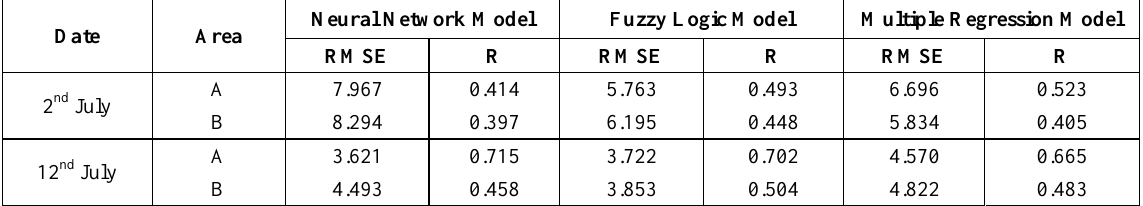
Table 3. Root means square error (RMSE) and correlation coefficient (R) of estimated soil moisture using neural network and fuzzy logic with ESTER soil moisture.